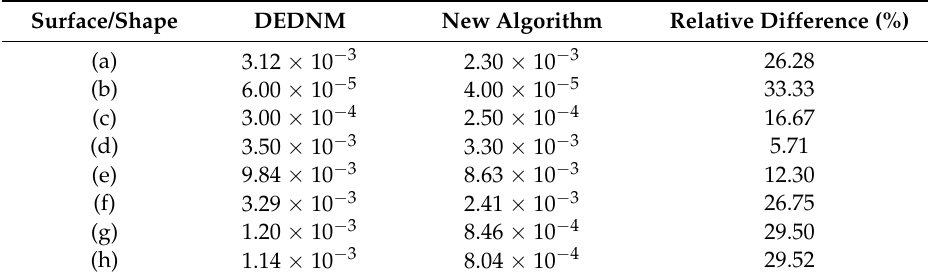
Table 1. Final total elevation increments for eight surfaces (a–h) calculated by DEDNM and the new algorithm.